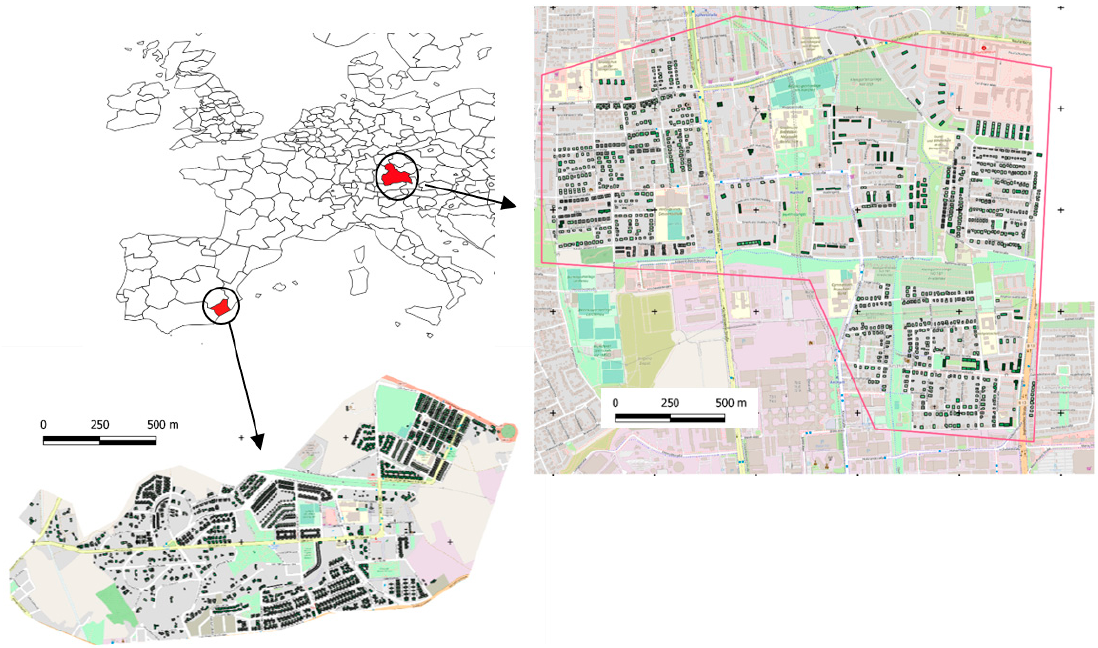
Table 1. Study areas characteristics.